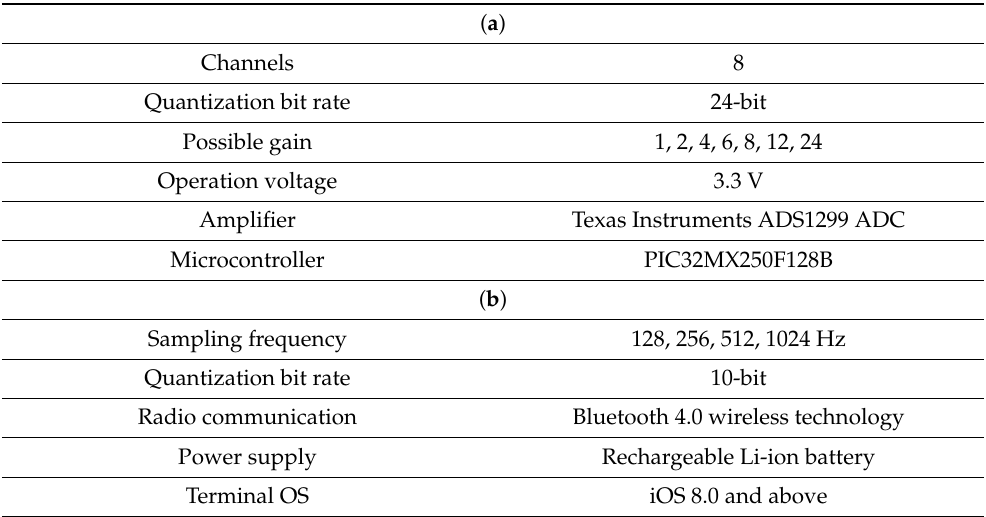
Table 1. Hardware specifications for ( a ) Ultracortex Mark IV (OpenBCI Inc., Brooklyn, NY, USA), and ( b ) Vitalgram (AffordSENS Corporation, Vitalgram, Figure 2c, Yokohama, Kanagawa, Japan),